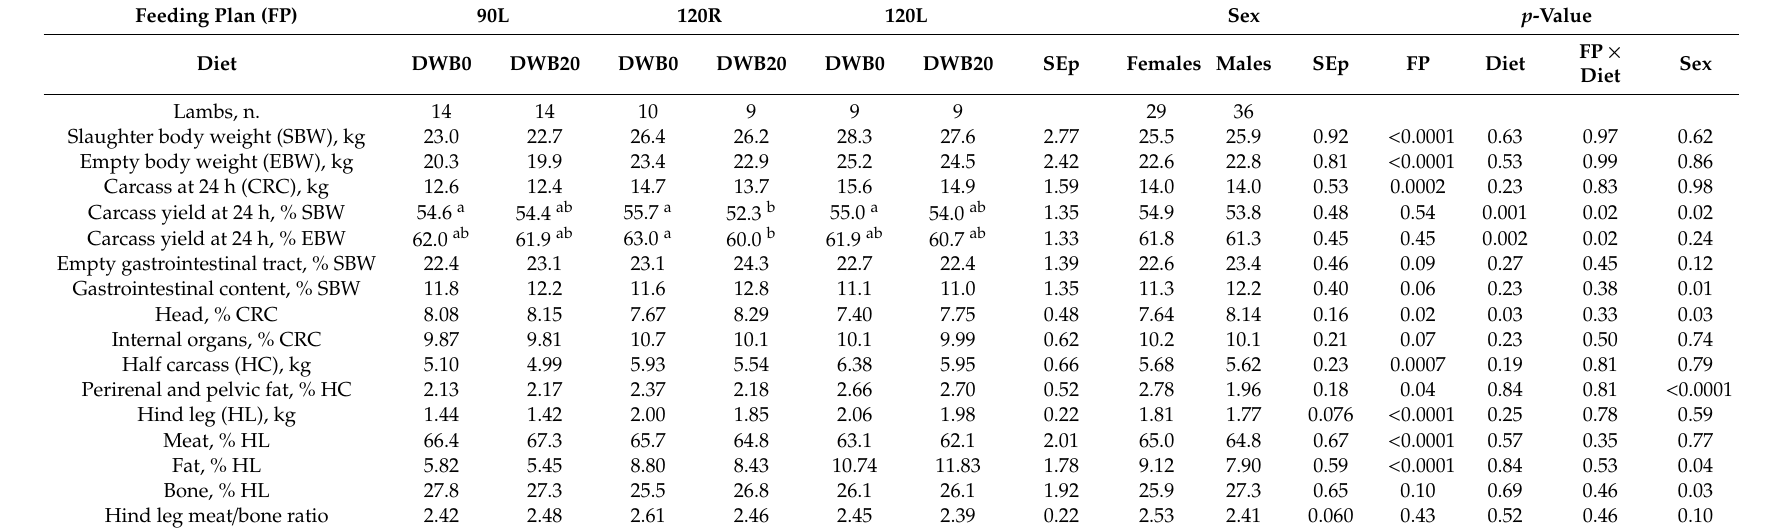
Table 4. Slaughter performance of lambs and carcass traits in relation to feeding plan, diet and